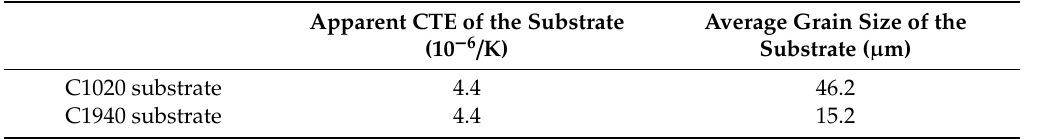
Table 2. Properties of copper